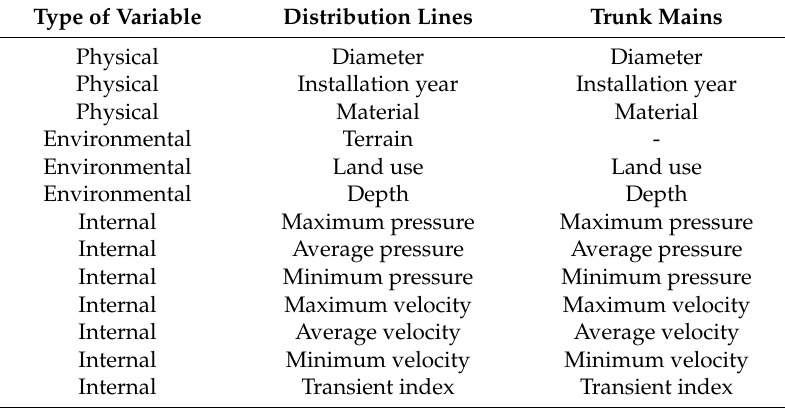
Table 2. Considered